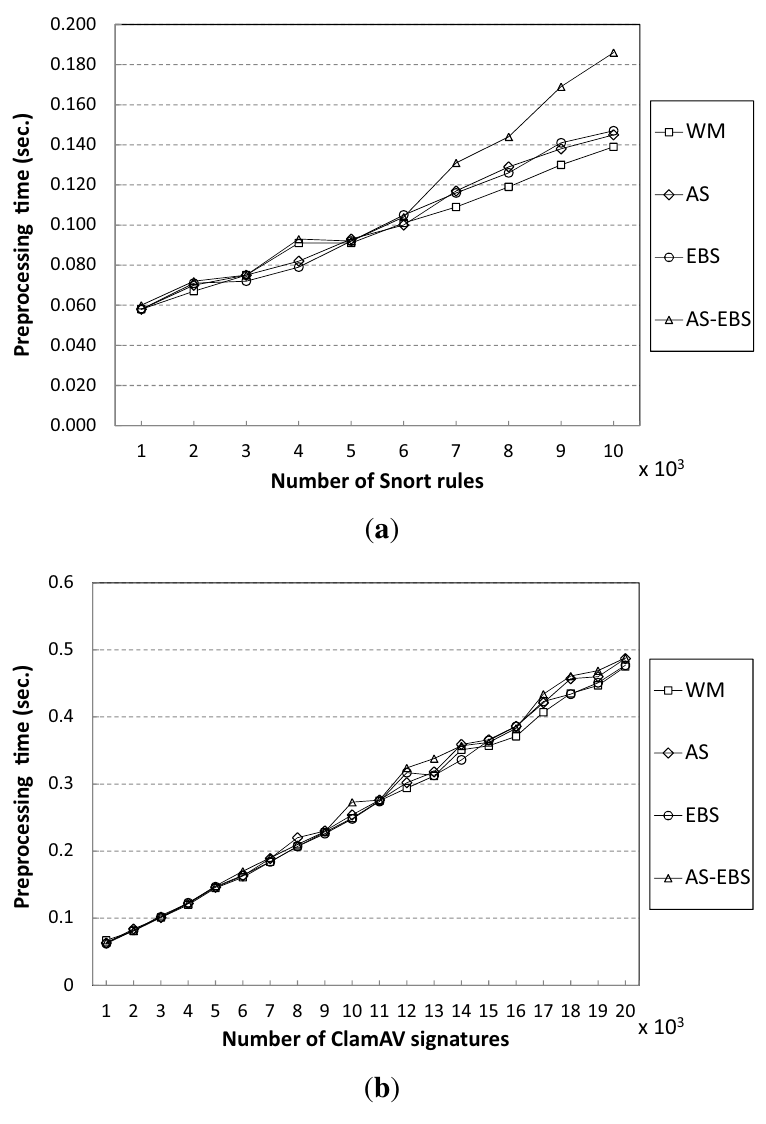
Figure 13. Preprocessing times of pattern-matching algorithms. ( a ) Snort; ( b )